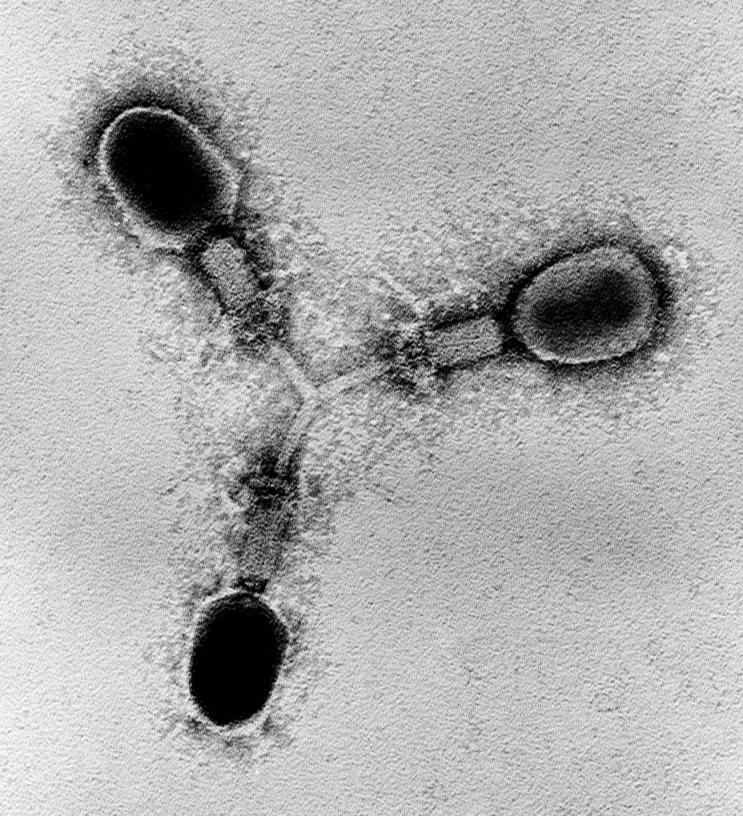
Cyanophages–viruses that infect photosynthetic marine bacteria–not only possess genes for photosynthesis but also exchange genetic material with their cyanobacterial hosts.